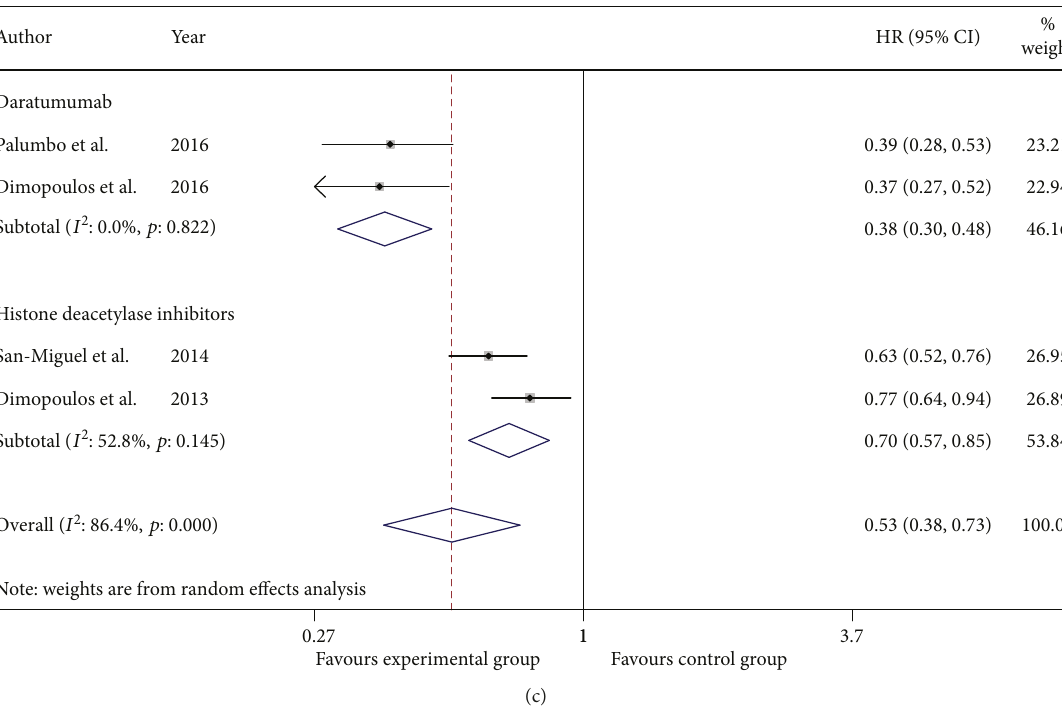
Figure 2: Meta-analysis of the e ffi cacy of MAb group and HDACi group in patients with RRMM: (a) hazard ratio for progression free survival of MAb group and HDACi group versus their corresponding control group; (b) hazard ratio for overall survival of MAb group and HDACi group versus their corresponding control group; and (c) hazard ratio for progression-free survival of daratumumab group and HDACi group versus their corresponding control group. “ P = 0 000 ” in Figure 2(a) and Figure 2(c), which was automatically generated by Stata software, represents P ≤ 0 001 actually, denoting that there exists heterogeneity among